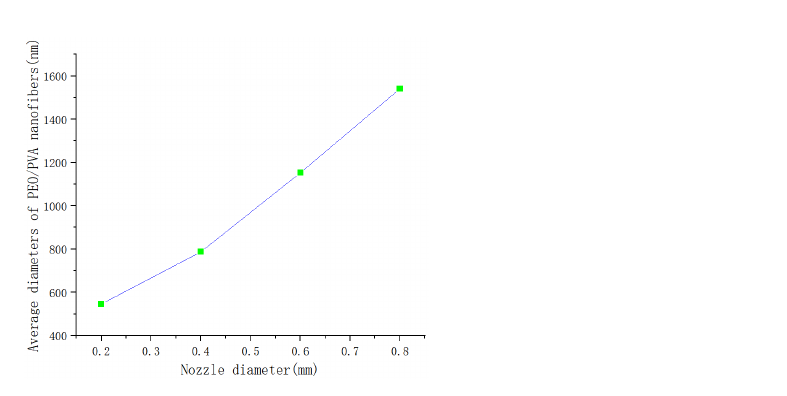
Figure 10. PEO/PVA composite nanofibers at different nozzle diameters. ( a ) 0.2 mm; ( b ) 0.4 mm; ( c ) 0.6 mm; ( d ) 0.8 mm.